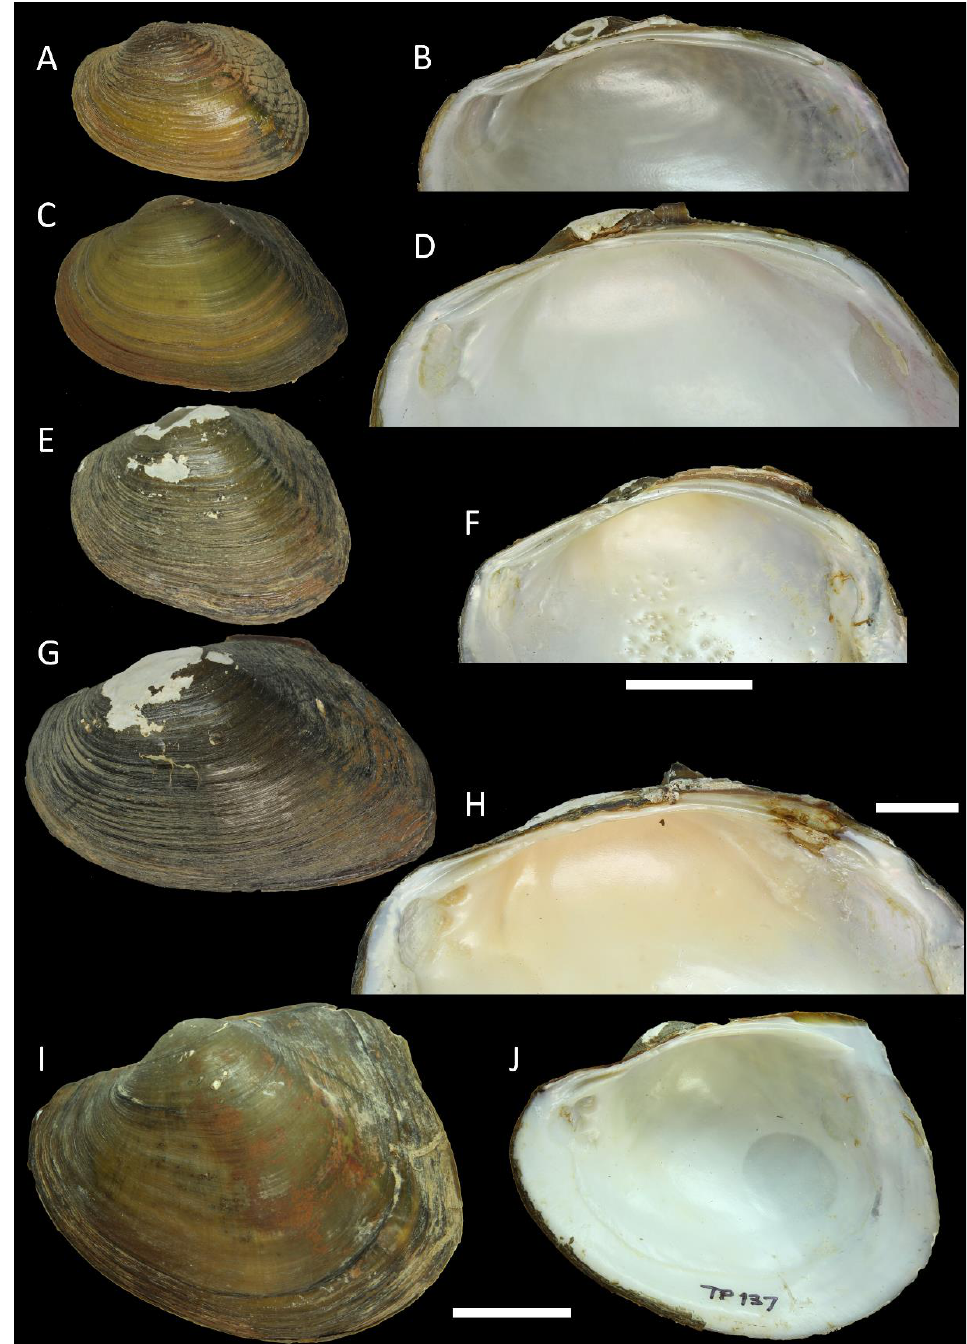
Figure 4. Shells of Lens and Physunio (Contradentini) members from Southern Thailand. ( A , B ) Lens contradens (Lea, 1838), specimen RMBH biv 1274/10, Main Klong Min River, Nakhon Si Thammarat Province: ( A ) left valve view, ( B ) zoom inside view of right valve; ( C , D ) L. contradens , specimen RMBH biv 1275/1, Main Klong Sok River, Surat Thani Province: ( C ) left valve view, ( D ) zoom inside view of right valve; ( E , F ) L. contradens , specimen RMBH biv 1280, Main Tapi River, Nakhon Si Thammarat Province: ( E ) left valve view, ( F ) zoom inside view of right valve; ( G , H ) L. contradens , specimen RMBH biv 1278, Main Tapi River, Surat Thani Province: ( G ) left valve view, ( H ) zoom inside view of right valve; ( I , J ) Physunio superbus (Lea, 1843), specimen RMBH biv 1277/1, Main Tapi River, Surat Thani Province: ( I ) left valve view, ( J ) inside view of right valve. Scale bar = 20 mm ( A , C , E , G , I , J ); scale bar = 10 mm ( B , D , F , H ). Photos: Ekaterina S.